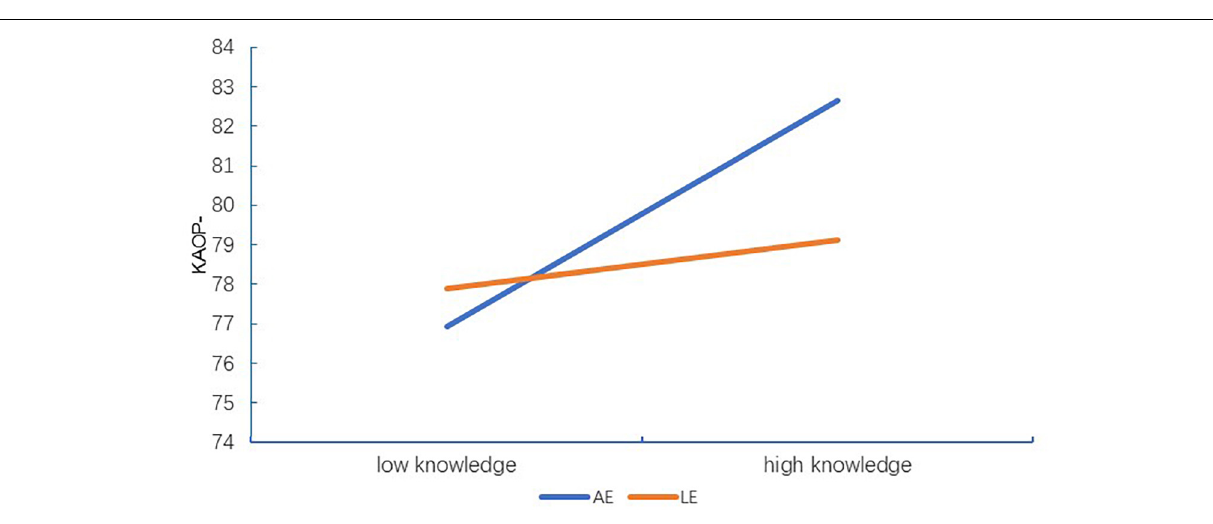
FIGURE 3 | Interaction effect of empathy profile and knowledge of aging on negative attitude toward older adults among nursing students. KAOP, total mean scores of Kogan’s Attitude Toward Older People Scale; KAOP–, negative KAOP; AE, average empathy subgroup; LE, low empathy